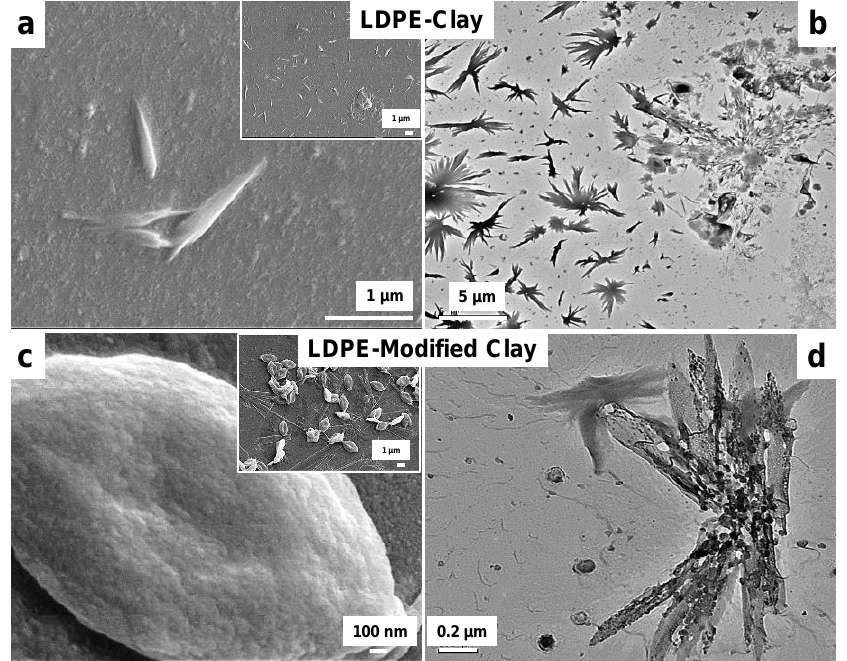
Figure 2. SEM ( a ) and TEM ( b ) micrographs of LDPE-Clay, while ( c , d ) are corresponding micro- graphs of LDPE-modified clay. INSET images are corresponding low magnification images. The magnifications in the micrographs are as: a: 25 k; a’ (INSET): 5 k; b: 7 k; c: 40 k; c’ (INSET): 8 k; and d: 10 k. The SEM chamber pressure varied from 1.4 × 10 −6 mbar – 4 × 10 −6 mbar.